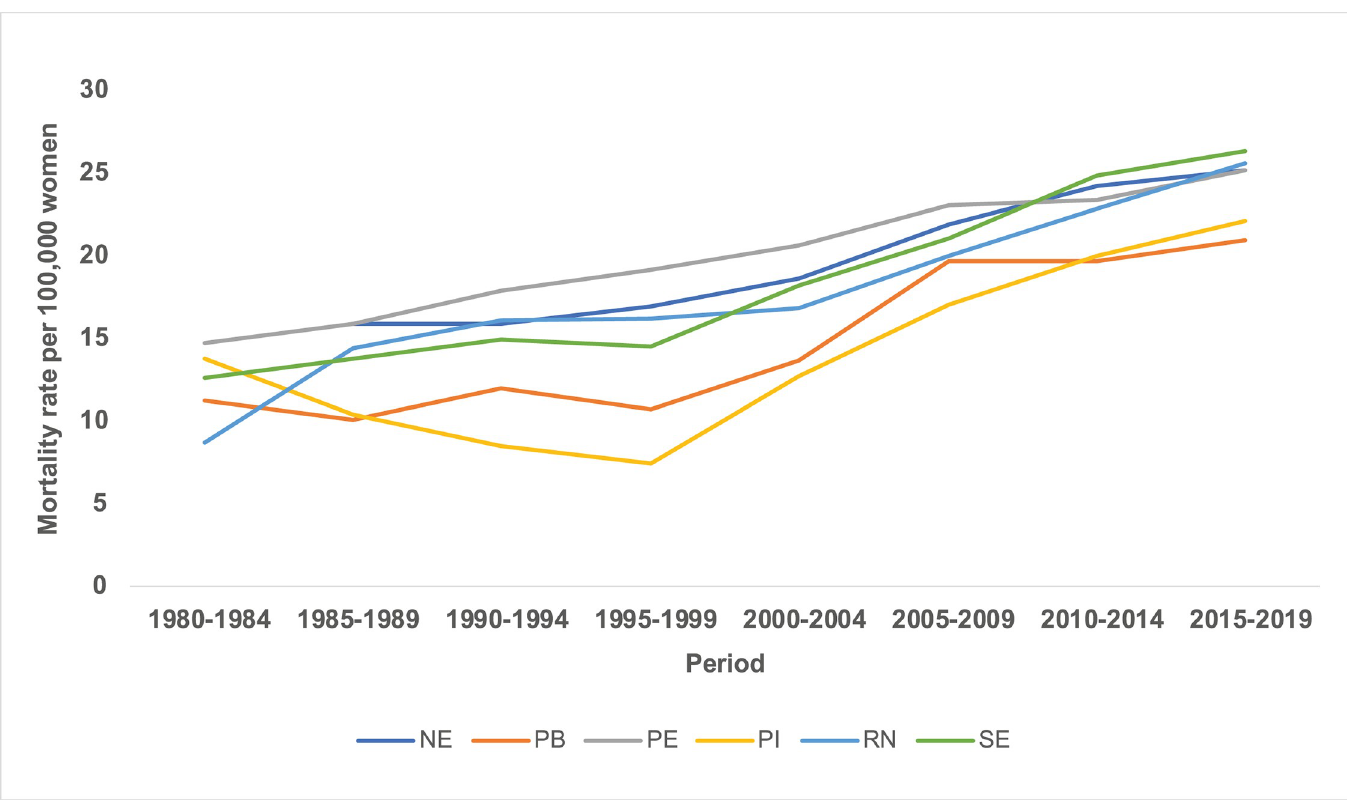
Fig 4. Mortality rates for breast cancer in the Northeast states of Brazil, by period 1980 to 2019.